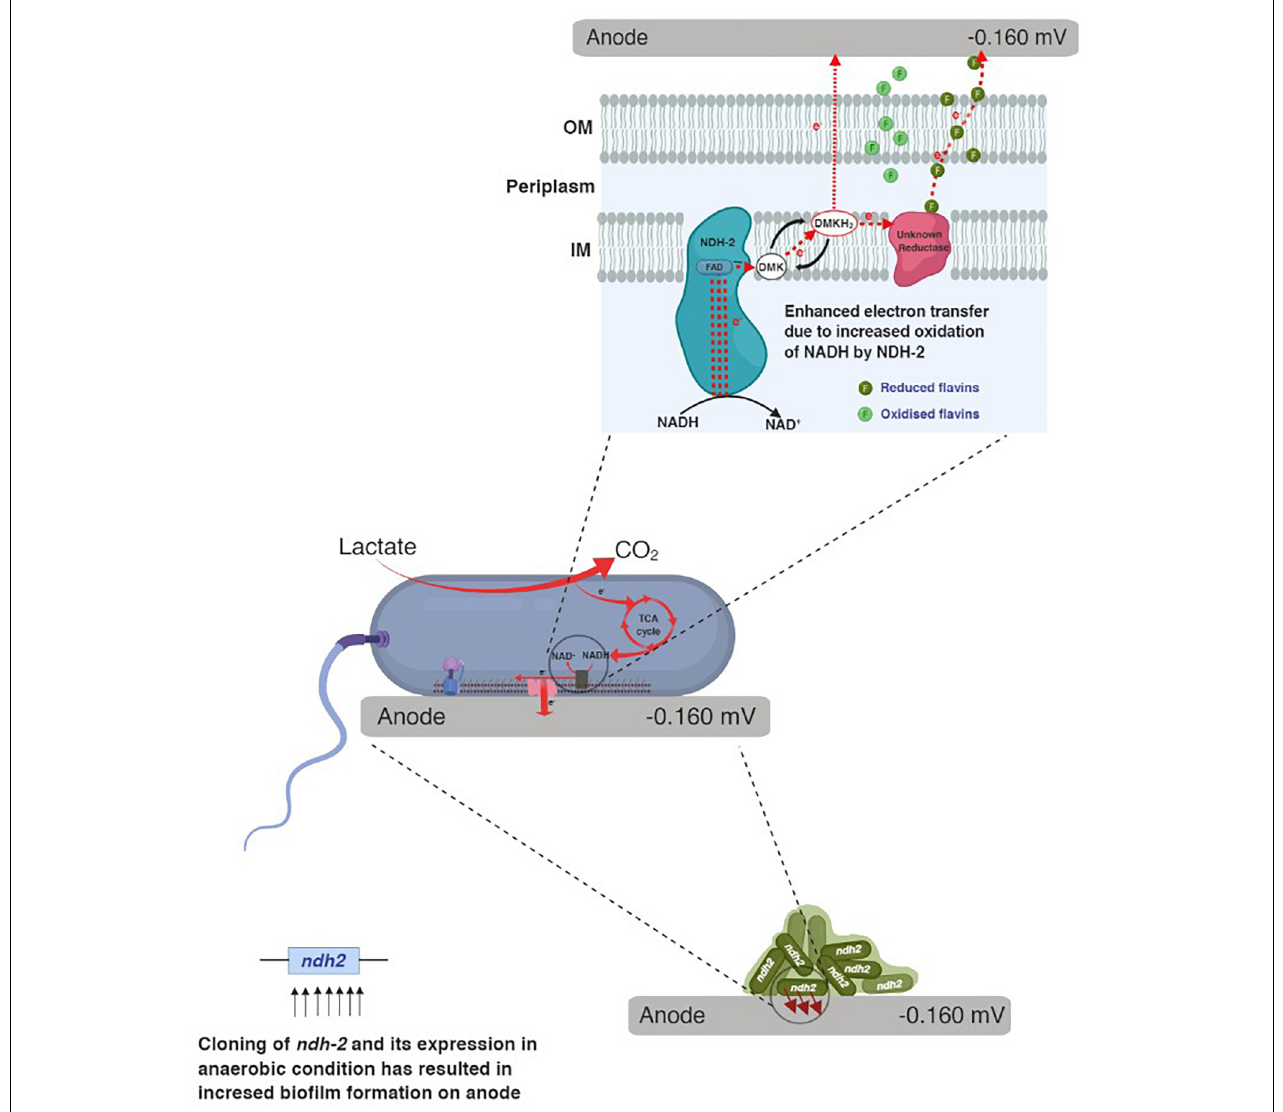
FIGURE 11 | A hypothetical mechanism for extracellular electron transport in NDH-2 induced